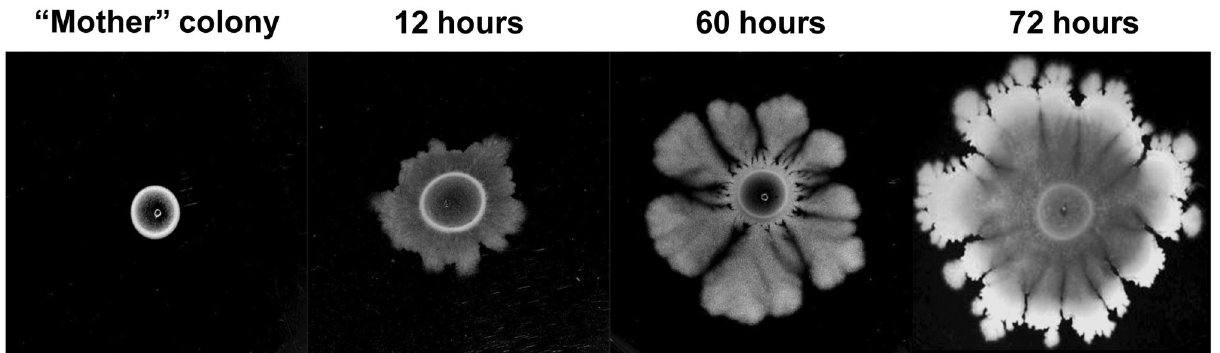
Figure 1. The typical complex colony development phenotype of B. subtilis 3610. Approximately 10 5 cells from the mid logarithmic growth stage were spotted on spreading plates containing 1.2% agar and incubated at 37°C as described in Methods. The plates were photographed at various time points (12, 60 and 72 hours) after inoculation. The presented results are representative of five independent